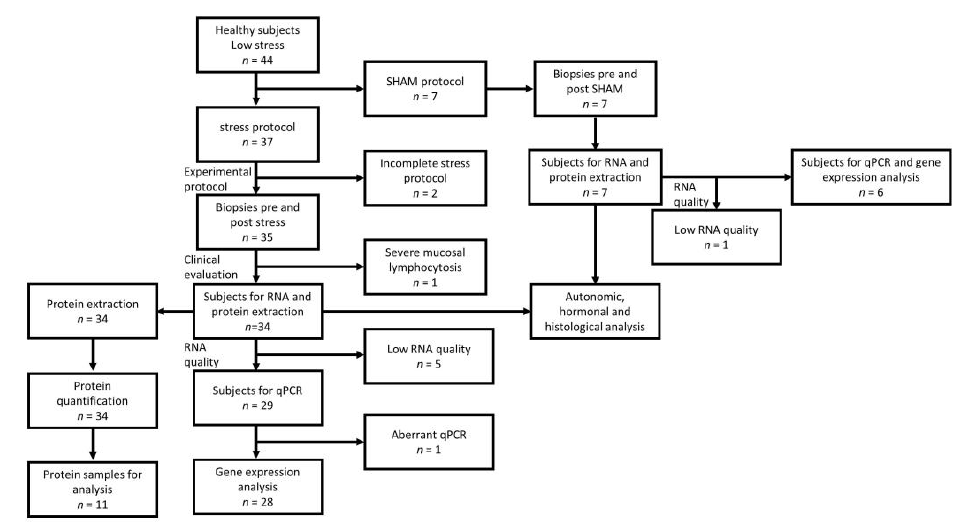
Figure 2. Flow chart of subjects’ inclusion and analysis.